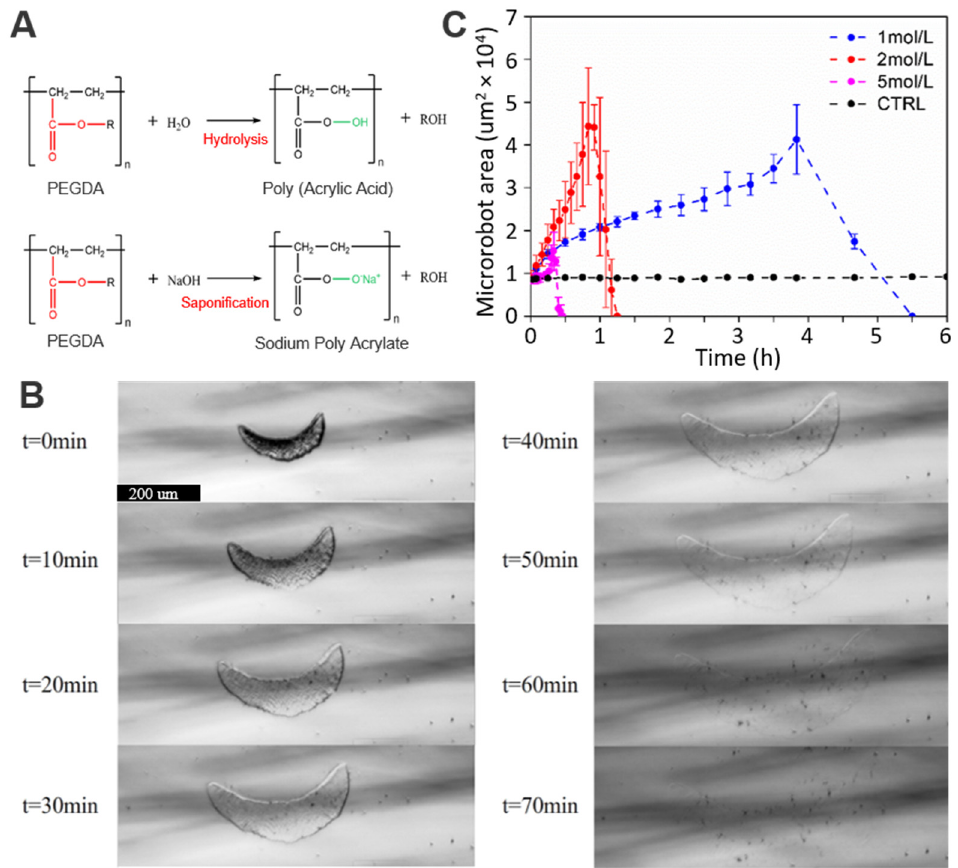
Figure 3. ( A ) First row: hydrolysis of the hydrogel microswimmer; second row: accelerated hydrolysis under the action of sodium hydroxide. ( B ) Optical microscope images of the degradation process of a hydrogel microswimmer with a 2 mol/L NaOH solution; the sample size was 3. ( C ) Relationship between the degradation time of the microswimmers and the concentration of the NaOH